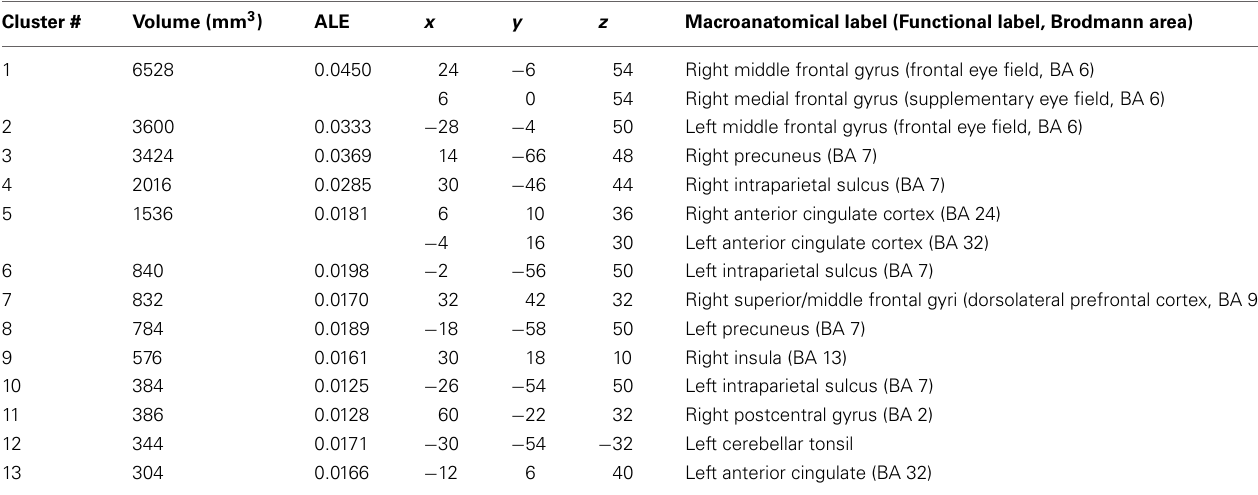
Table 4 | Talairach coordinates, volume (mm 3 ), ALE values and anatomical labels for the antisaccade > prosaccade analysis. Cluster